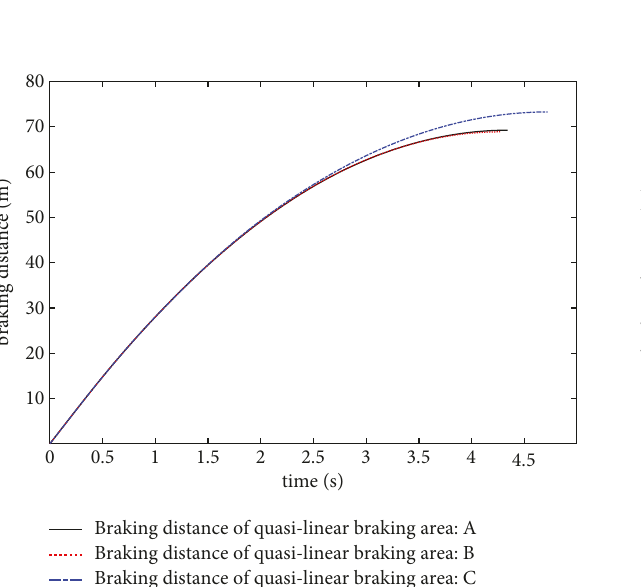
Figure 5: Braking distance in quasilinear area.